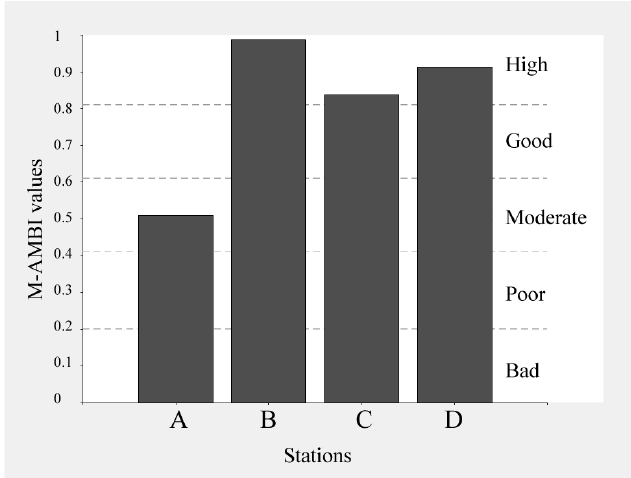
Figure 3. M-AMBI values in February 2018 for the 4 sites.